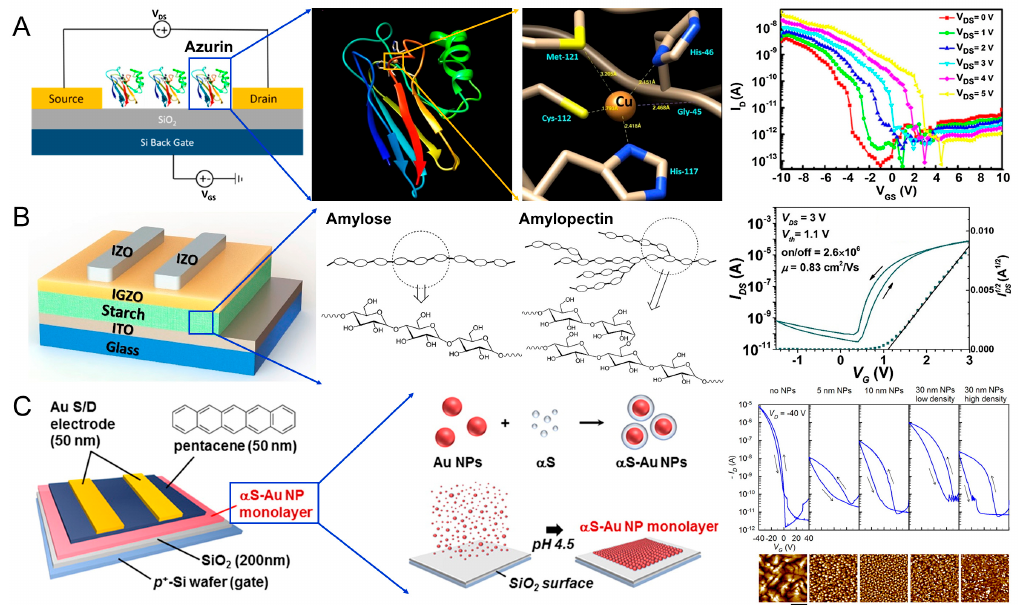
Figure 2. ( A ) Schematic illustration of azurin-based FET. Crystal structure (generated by UCSF Chimera, https://www.cgl.ucsf.edu/chimera) of native Pseudomonas aeruginosa azurin. Structural depiction of the metal site in native azurin (PDB ID: 1AZU). Cu-azurin FET—Drain current versus gate to source voltage with drain to source voltage varying between 0 to 5 V in steps. Reproduced with permission from [64], published by Elsevier, 2017. ( B ) Device structure of the thin film transistors with starch as the ion-based gate dielectric. Basic structural motifs of amylose and amylopectin. Transfer curves of IGZO transistors gated by starch dielectrics of glycerol incorporated potato starch. Reproduced with permission from [69], published by Elsevier, 2017. ( C ) Structure of the organic FET-based memory with protein-NP conjugate monolayer structure. Schematic representation of the α S–Au NP monolayer formation on SiO 2 . Specific interaction of α S (blue) with Au NPs (red) produces the homogeneous conjugates of α S − Au NPs (upper row). Bu ff er change from pH 6.5 to 4.5 induces adsorption onto SiO 2 , leading to the closely packed monolayer (lower row). Dual-sweep transfer curves for di ff erent α S–Au NP structures. Corresponding AFM images of the 50 nm thick pentacene channel are presented below. Adapted with permission from [72]. Copyright 2016 American